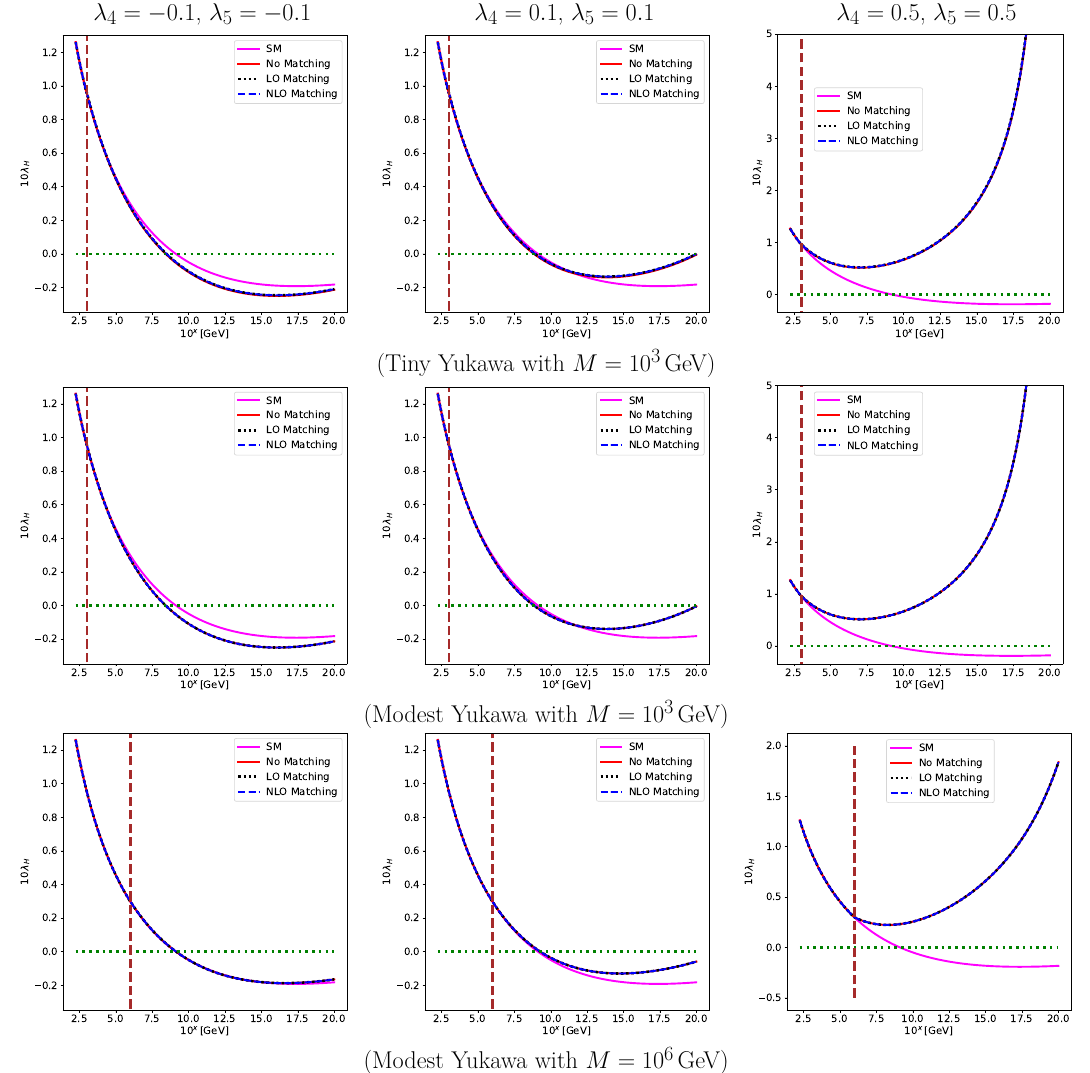
Figure 9 . Same as figure 7 but for the running of λ H